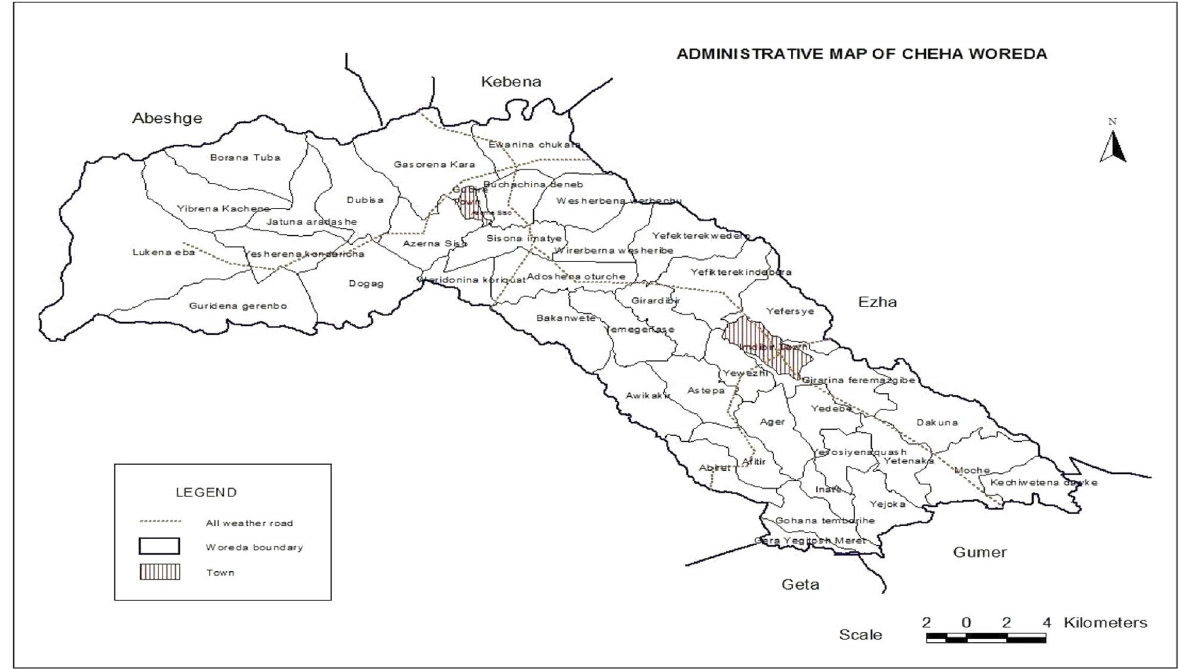
Fig. 2 An image of administrative map of